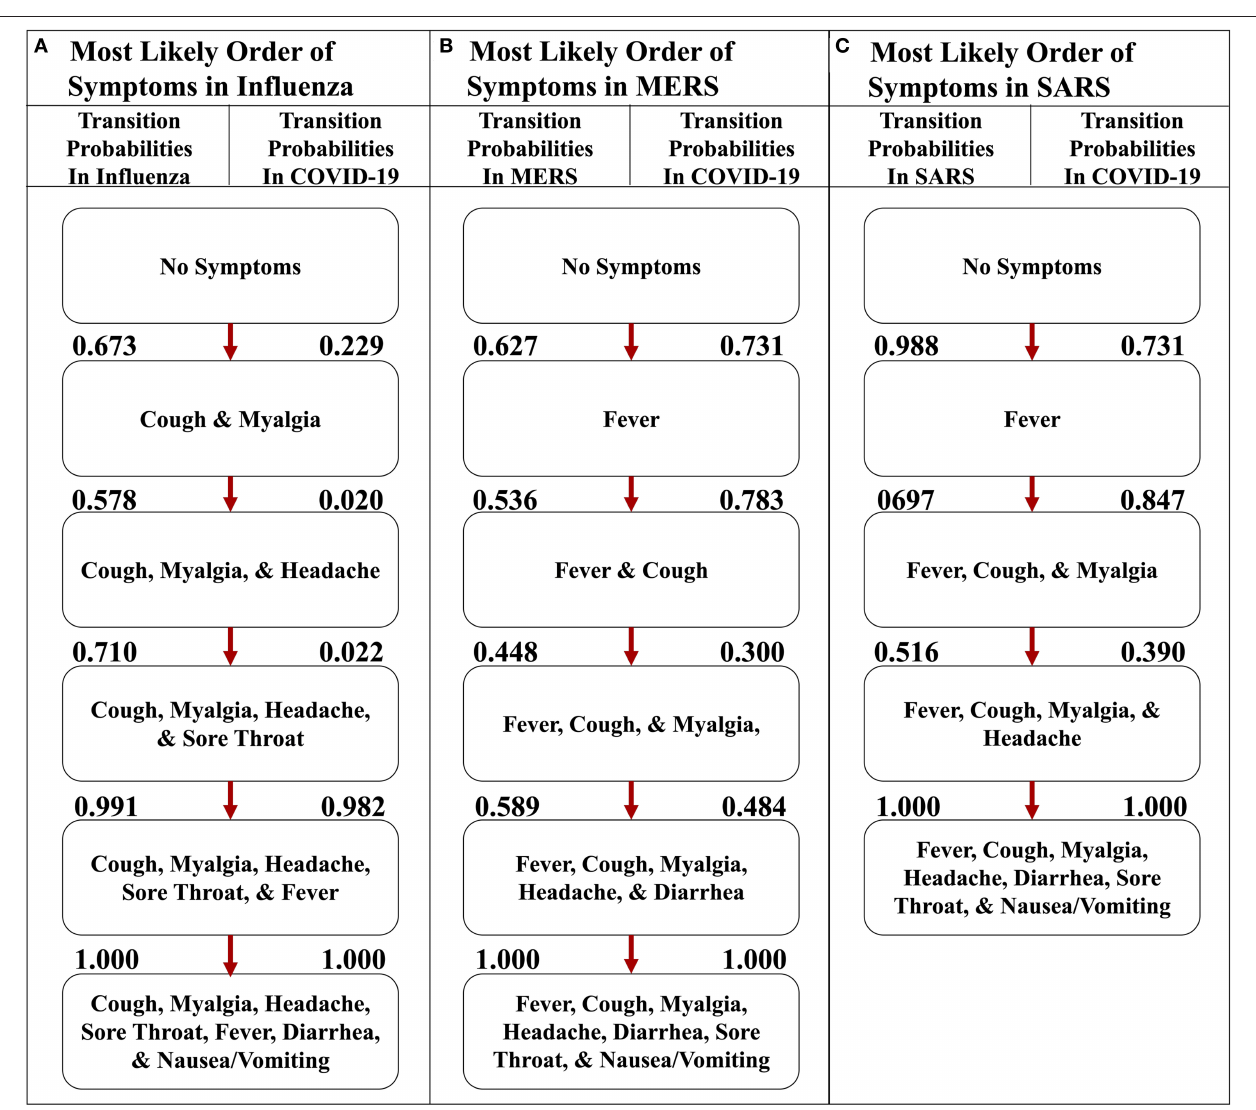
FIGURE 5 | The most likely paths of symptoms in influenza, MERS, and SARS vs. COVID-19. (A) The most likely path of seven common symptoms of influenza with the transition probabilities listed between nodes. (B) The most likely path of seven common symptoms of MERS with the transition probabilities listed between nodes. (C) The most likely path of seven common symptoms of SARS with the transition probabilities listed between nodes. For each path, the transition probabilities in COVID-19 are listed on the right. The most likely paths for each respective disease here are determined from the transition probabilities listed between nodes on the